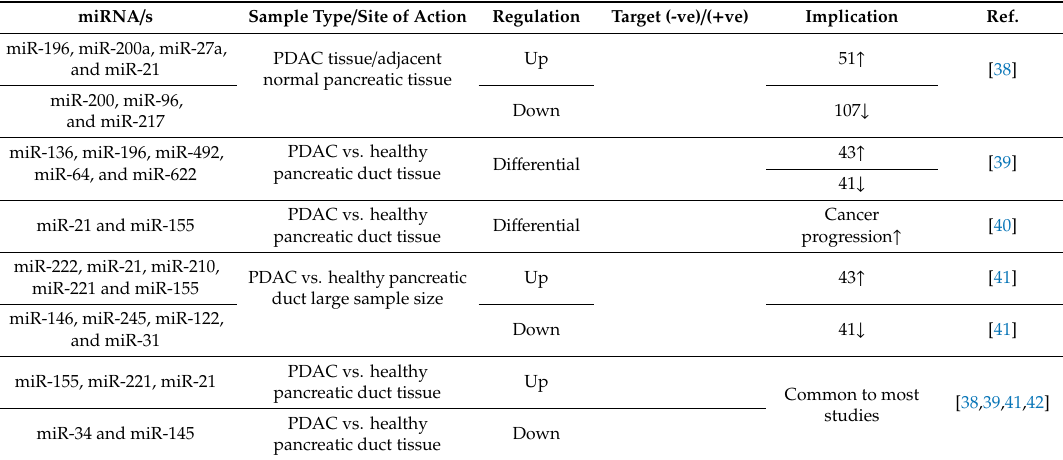
Table 1. Summary of di ff erentially expressed microRNAs with their targets and implications in pancreatic